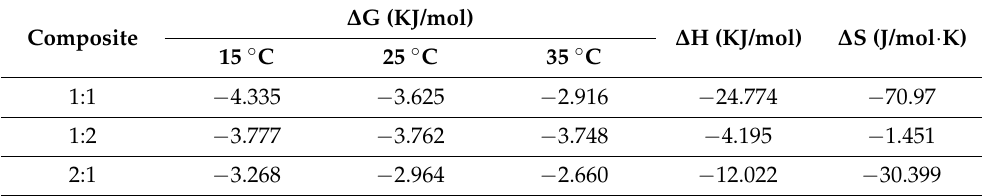
Table 4. Thermal parameters for the adsorption of